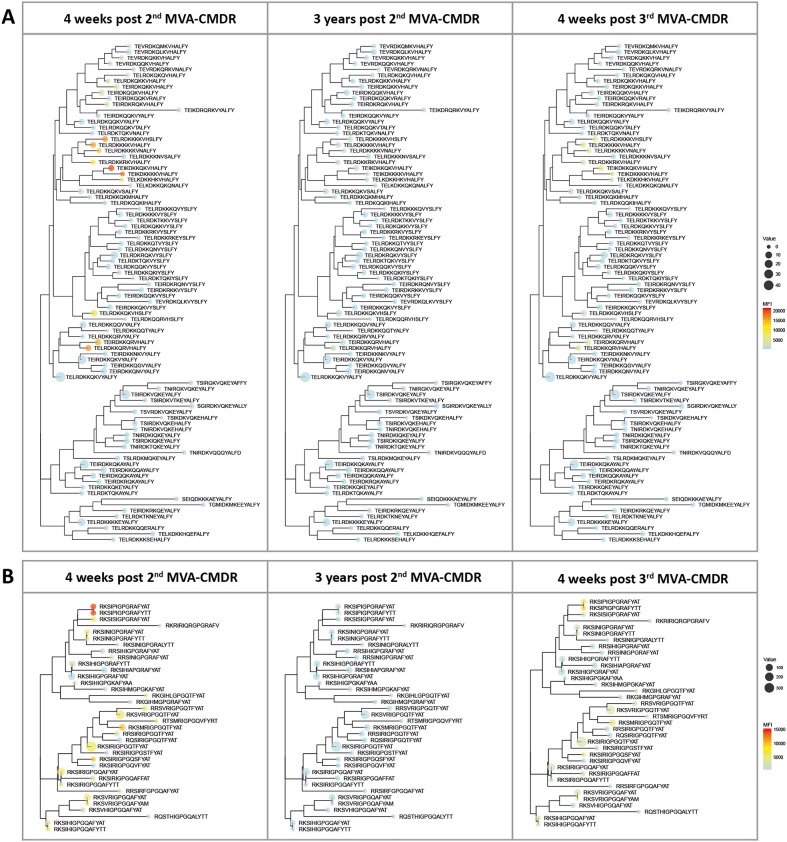
Phylogenetic heat map of IDR_V2 and IDR_V3 peptide variants targeted by vaccine-induced antibodies in HIVIS03/06 vaccinees. The strength of antibody-responses of all 20 vaccinees tested against each peptide variant (mean FI) corresponding with either IDR1_V2 or IDR2_V3, both of which were correlated to a reduced risk of HIV-infection in RV144, was calculated for each time point. The mean FI is illustrated in the context of their phylogenetic relationship, as well as their frequency of occurrence in the HIV database. The color of the dots represents the strength of the IgG response toward the given peptide, with a strong reaction displayed in red and a weaker reaction being displayed in blue. The icon size corresponds to the frequency of this peptide within the global HIV epidemic (www.hiv.lanl.gov) with a larger dot indicating a greater prevalence of the peptide. (A) Phylogenetic tree of 86 peptide variants corresponding to the HxB163_TGMIDKMKEEYALFY V2 position. (B) 36 peptide variants were tested for the V3 tip region (HxB304_RKSIRIGPGSTFYAT).